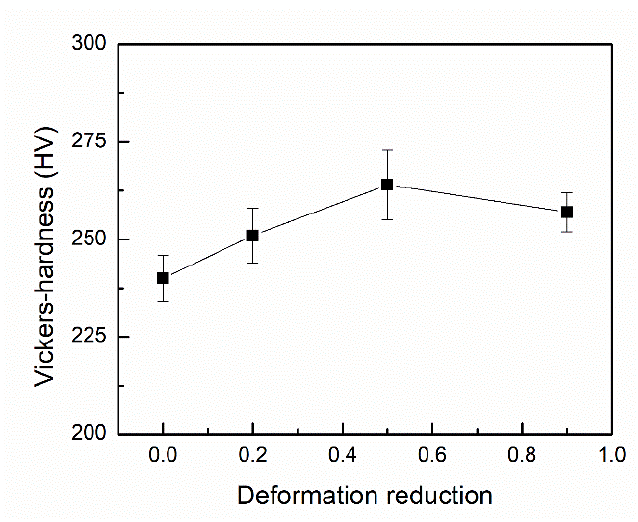
Figure 14. Vickers hardness of the low-carbon ferritic stainless steel samples with the different deformation reductions.